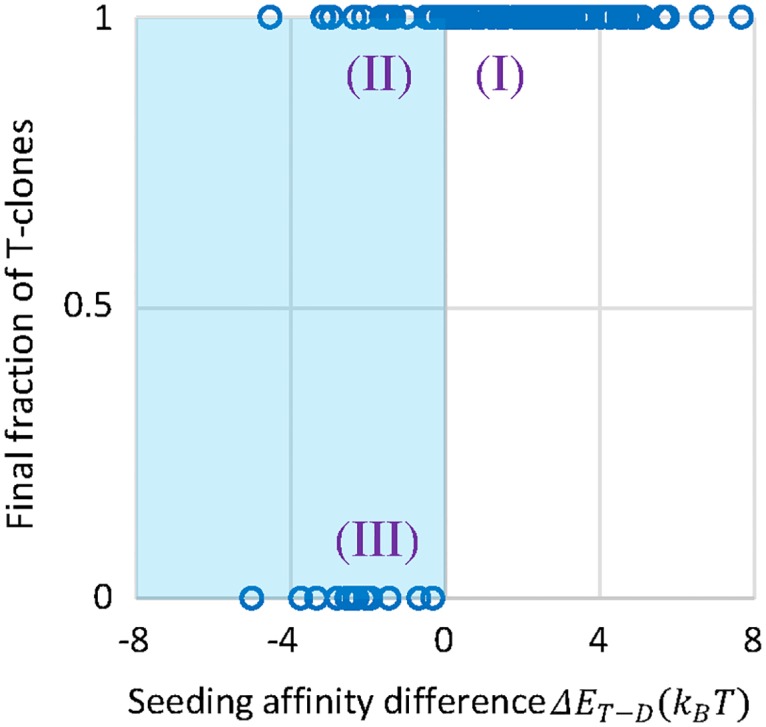
Clone fate in fluctuating environments.The scatter plot shows the dependence of clone fate, measured by the final percentage of T clones in a surviving GC, on the affinity difference between T and D seeding clones at the start of the v-period in scheme G|v1+v2, see 1 Ag. The affinity of a T clone is an average of affinities with respect to the two variants. Each symbol is a surviving GC. All the surviving GCs co-seeded by T and D clones are dominated by one subpopulation when mature, i.e., the final percentage of T clones is either 0% or 100%. Three regimes of clone fate are noted. Regime I (60% of surviving GCs): higher mean affinity of T seeding clones guarantees their dominance upon maturation. Regimes II and III (shaded area): lower mean affinity of T seeding clones leads to uncertainty in the dominant species. T-winning (regime II) and D-winning (regime III) cases occur with similar probabilities, 17% and 23%, respectively.